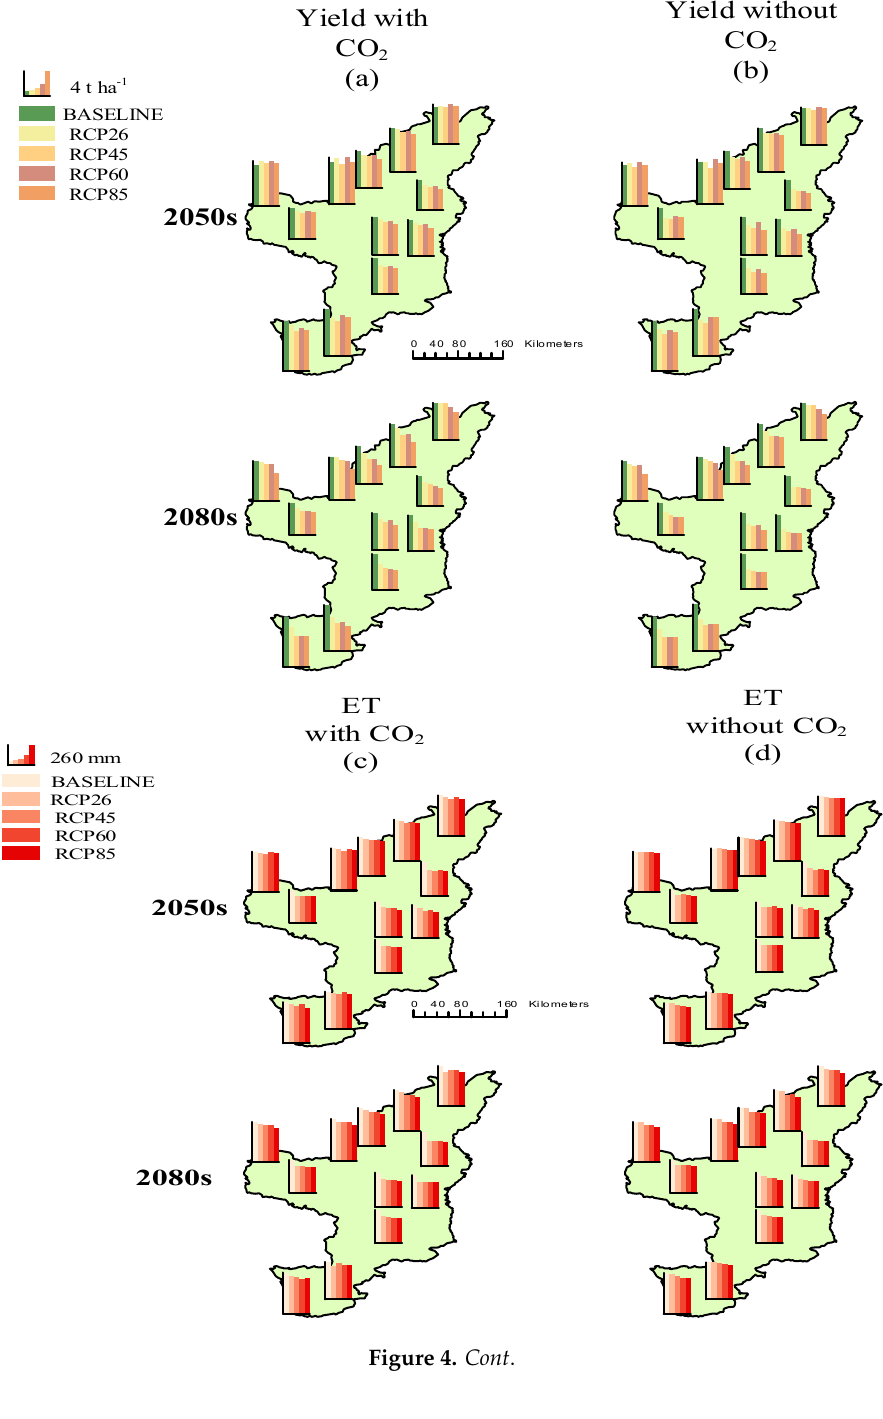
Figure 4. Cont Figure 4. Spatial and temporal evolutions of ( a , b ) the yields with and without CO 2 (t ha − 1 ), ( c , d )